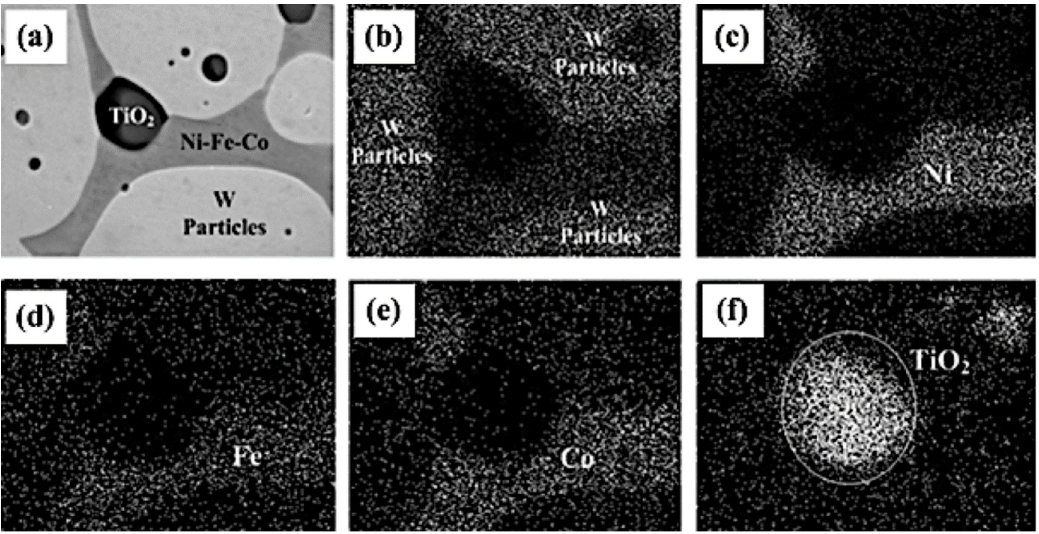
Figure 3. X-ray mapping of TiO 2 /Ni-Fe-Co-W alloy using SEM-EDS, where: ( a ) TiO 2 /Ni-Fe-Co-W, ( b ) W particles, ( c ) Ni, ( d ) Fe, ( e ) Co and ( f ) TiO 2 particles.